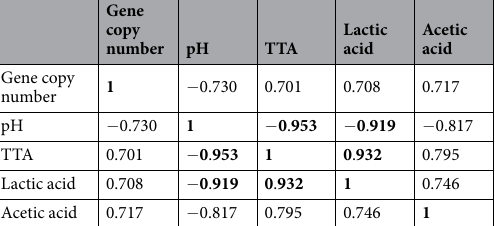
Table 3. Pearson correlation matrix between the gene copy number (Log gene copy/g) and the biochemical characteristics of laboratory and bakery sourdough breads. TTA, total titratable acidity. Boldface values (lower triangular matrix) represent highly correlated descriptors with values > 0.9 or <−